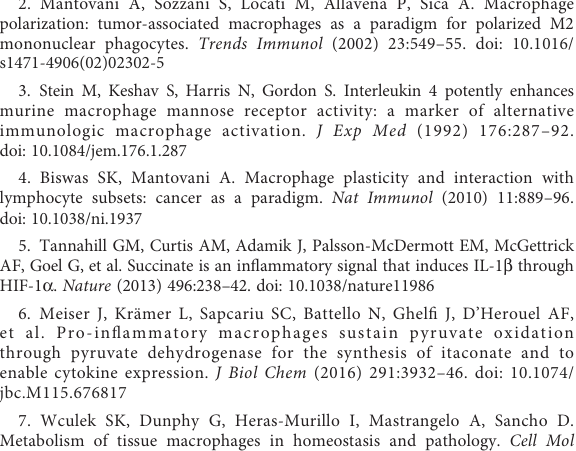
SUPPLEMENTARY FIGURE 1 Macrophage expression pro fi le at quiescence in response to metabolic inhibitors. Bone marrow-derived macrophages (BMDMs) were pretreated with metabolicinhibitors for30minandleftuntreated incleancellculture media for 2 h after. Surface expression levels of MHCII by fl ow cytometry in BMDM that are unstimulated or stimulated with LPS for 2 h or 24 h. All points are shown in box plots with line at median. ns not signi fi cant, * p<0.05, *** p<0,001, **** p<0,0001. Unless otherwise stated, differences between groups are not statistically signi fi cant. SUPPLEMENTARY FIGURE 2 MCP1 secretion by IL-4-stimulated BMDMs. Concentration of MCP1 in cell culture media of BMDMs pretreated with 2DG, Oligo, Rot/AA, Eto or Eto+2-DG and then stimulated with IL4 for 2h. All points are shown in box plots with line at median. One-way ANOVA was used to determine statistical signi fi cance between groups within each stimulation condition (untreated, LPS, IL4) * p<0.05, *** p<0,001, **** p<0,0001. Unless otherwise stated, differences between groups are not statistically signi fi